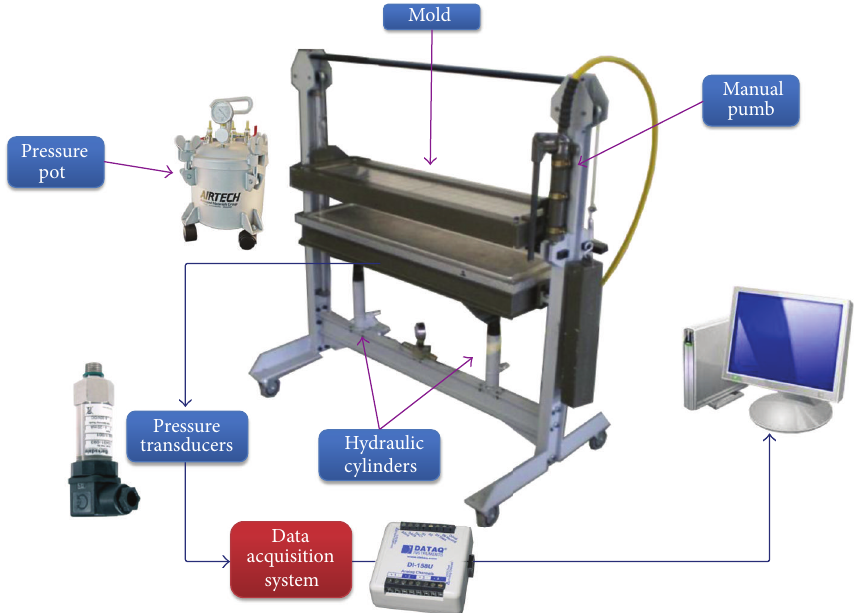
Figure 2: Setup for permeability measurements.